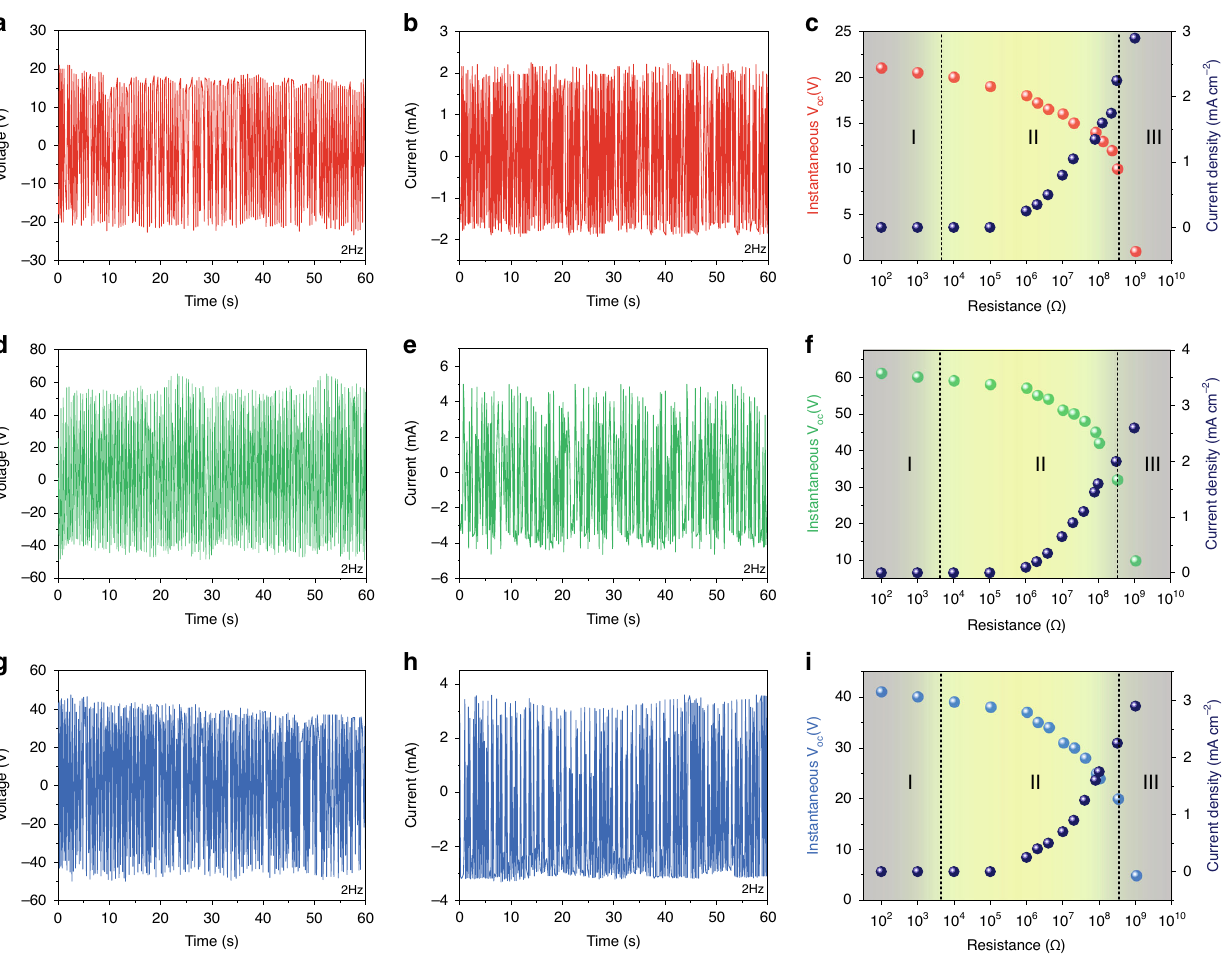
Fig. 4 The electrical performance under different aspect ratios. a , d , g The open-circuit voltages of Pem-iTENG with different aspect ratios. b , e , h The short-circuit currents of Pem-iTENG with different aspect ratios. c , f , i The transient voltage and current density of the Pem-iTENG at the external resistance of 10 2 Ω – 10 9 Ω